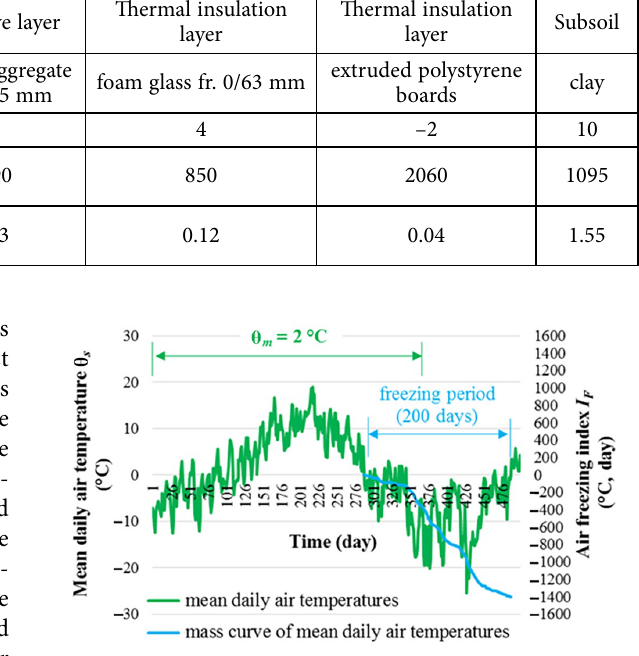
Figure 4. Maximum climate stres sused in the